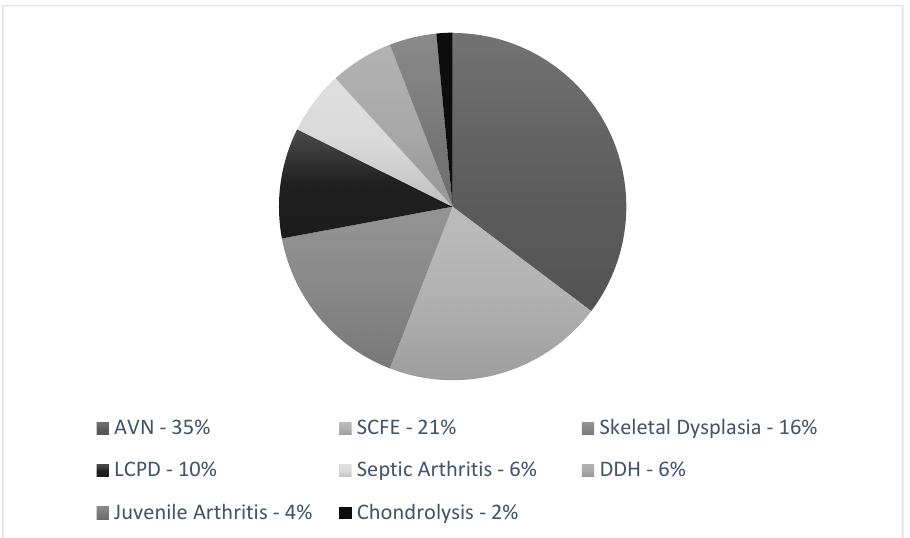
Figure 1. Causes of THR per patient. AVN: avascular necrosis; SCFE: slipped capital femoral epiphysis; LCPD: Legg-Calvè-Perthes disease; DDH: developmental dysplasia of the hip.